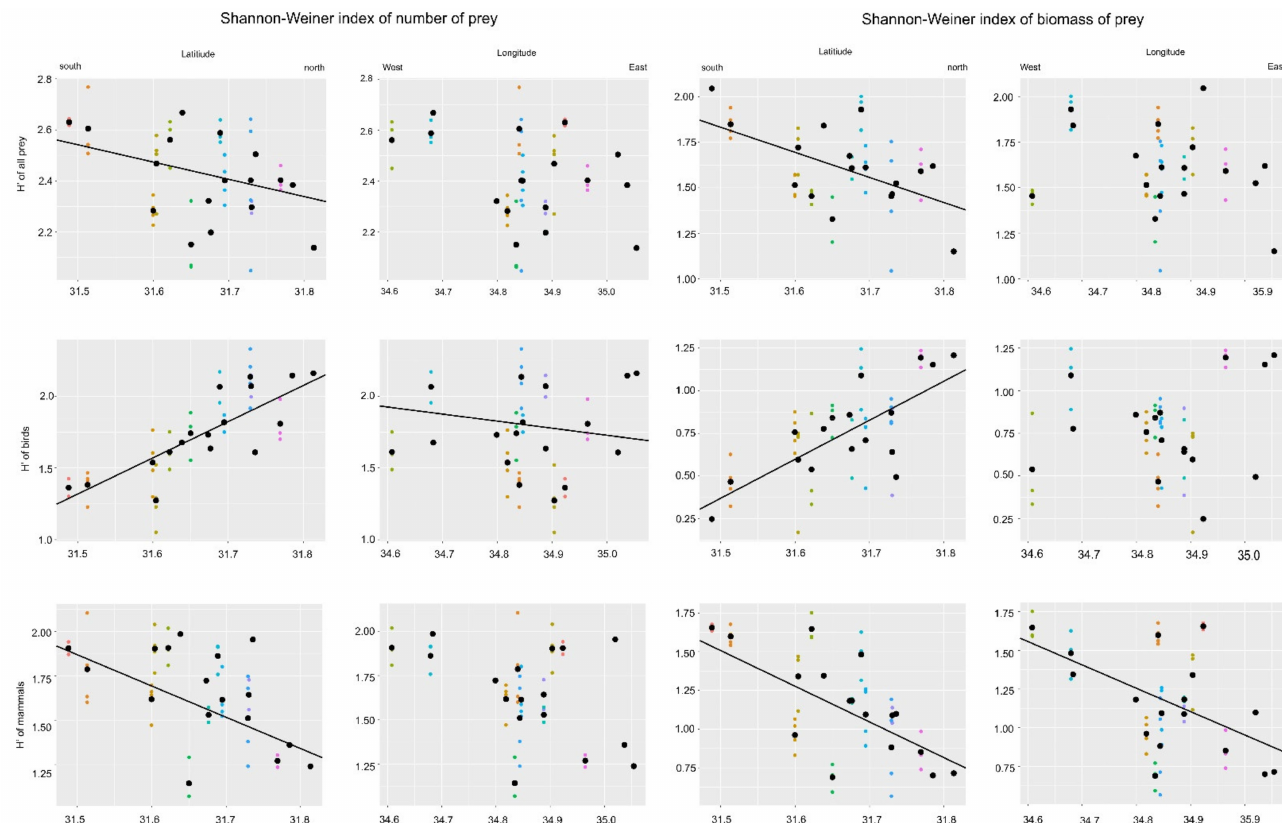
Figure 3. Relationship between longitude and latitude and the Shanon-Wiener Diversity Index for all prey, and birds and mammals. Circles of the same color denote the prey collected from the same nest of Eagle Owls ( Bubo bubo ) and black points indicate the mean value for the particular